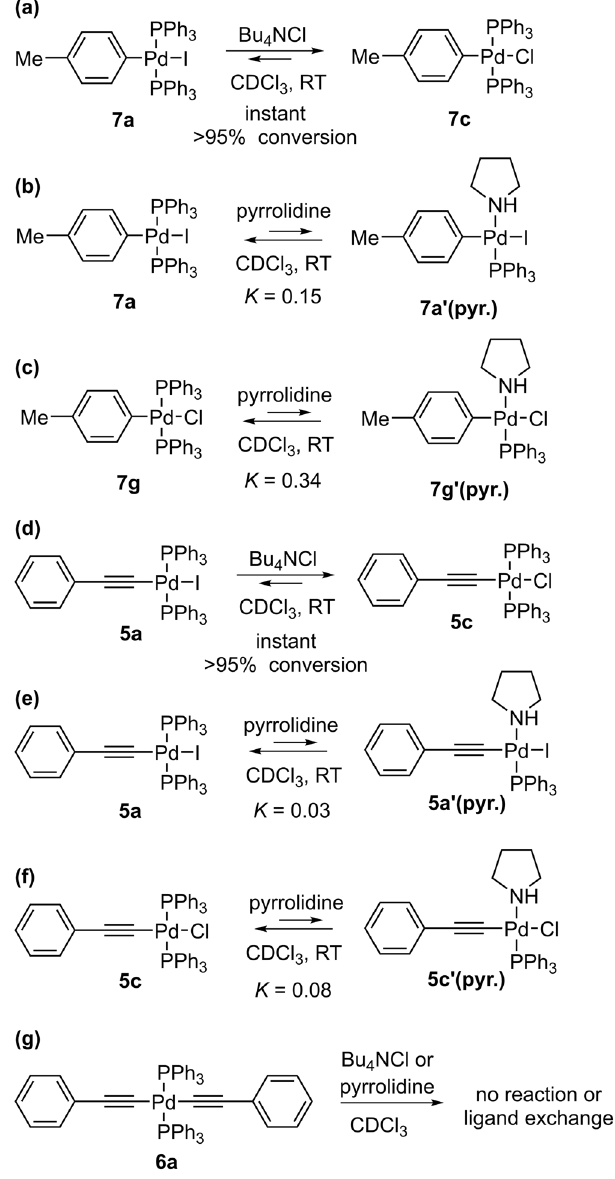
Fig. 11 Investigating proposed elementary reactions with addition of chloride ions and pyrrolidine. a – c Effect of pyrrolidine and chloride ions on structures 7 . d – f Effect of pyrrolidine and chloride ions on structures 5 . g Pyrrolidine and chloride ions have no effect on 6a . Conditions: 5a , 5c , 6a , 7a, 7g (0.01M), Bu 4 NCl (0.025 M) if added, pyrrolidine (0.05-0.15 M) if